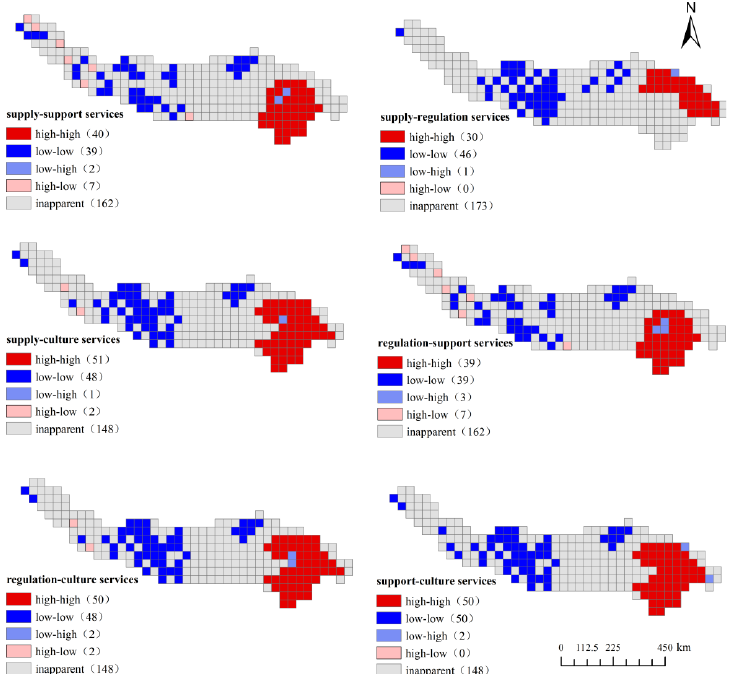
Figure 3. Grid-based LISA cluster map of ecosystem services in the Yarlung Zangbo river basin in 2020. High-high and low-low mean synergistic relationship, high-low and low-high mean trade-off relationship.